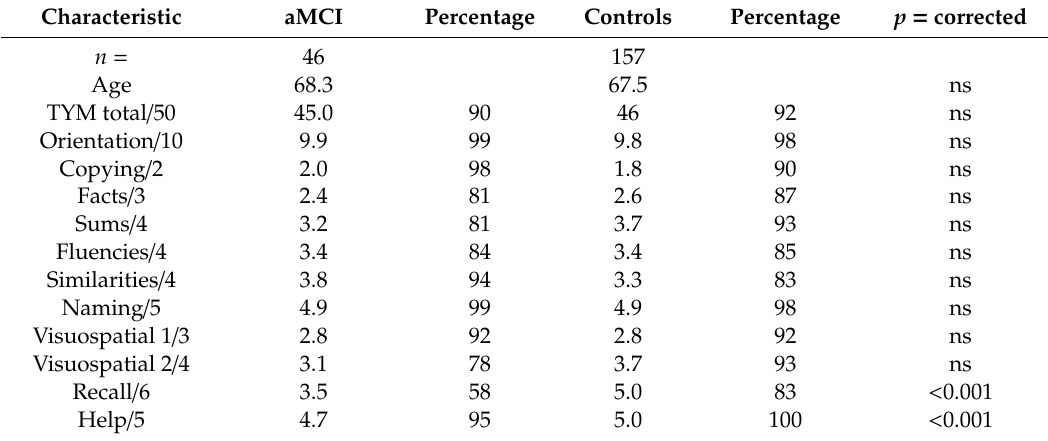
Table 5. Comparison of TYM and TYM subtest scores in patients with aMCI (amnestic mild cognitive impairment) who passed the TYM test compared to